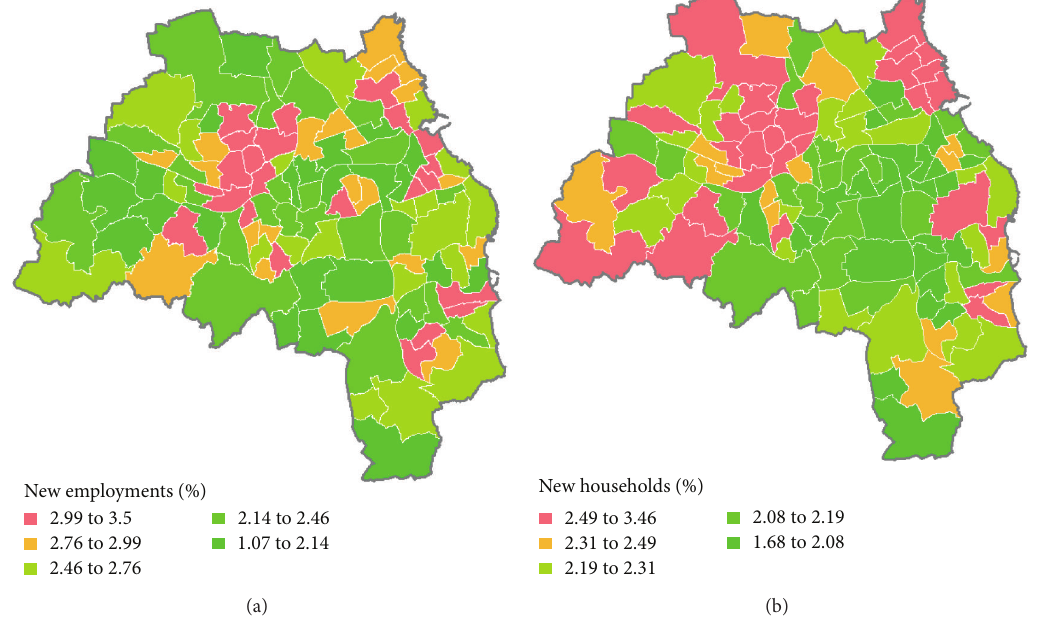
Figure 8: Household change by wards alongside employment growth, from 2008–2016. (a) Employment change (%) and (b) household change (%).